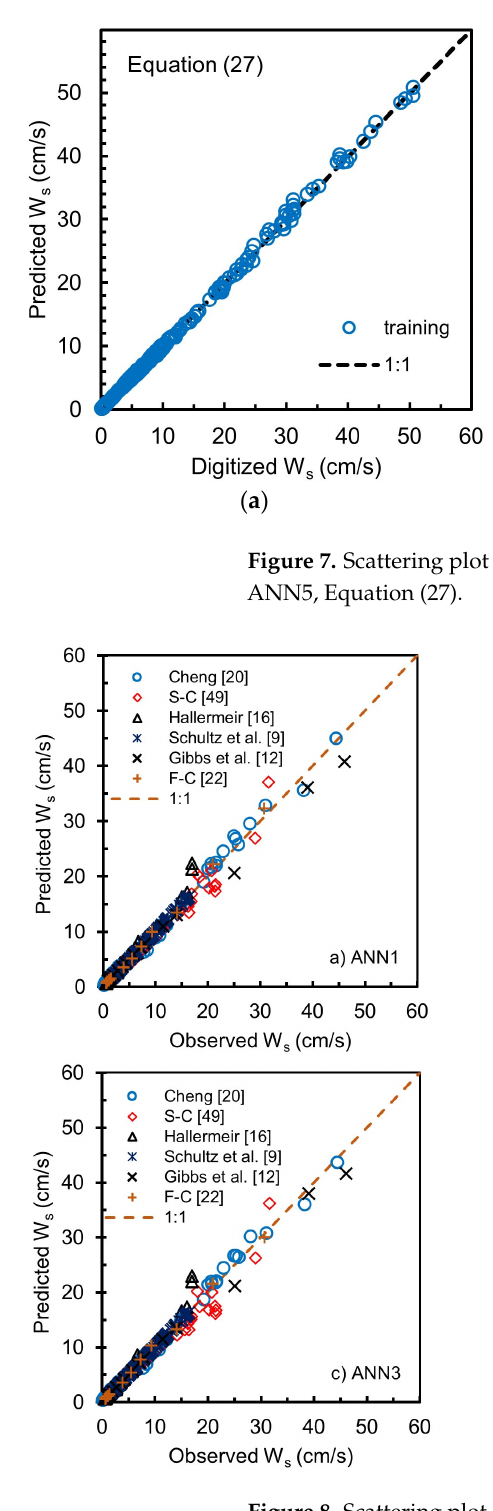
Figure 6. Scattering plot for results of model training ( a ); validation and testing 1 ( b ) for simplified ANN4, Equation (26).